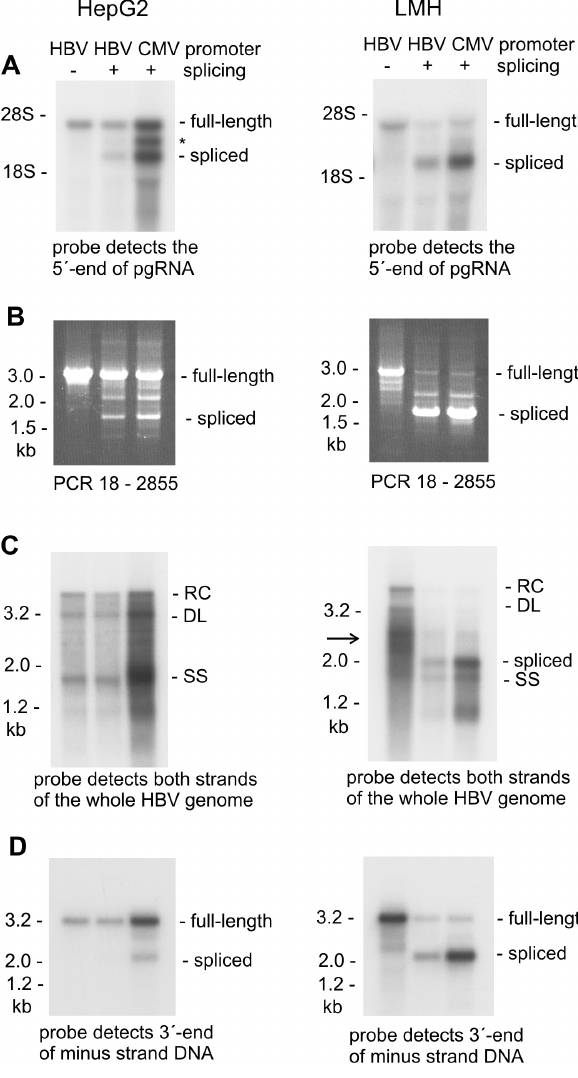
Figure 2. Comparison of HBV replication in human HepG2 and chicken LMH cells. The transfected plasmids are coding for